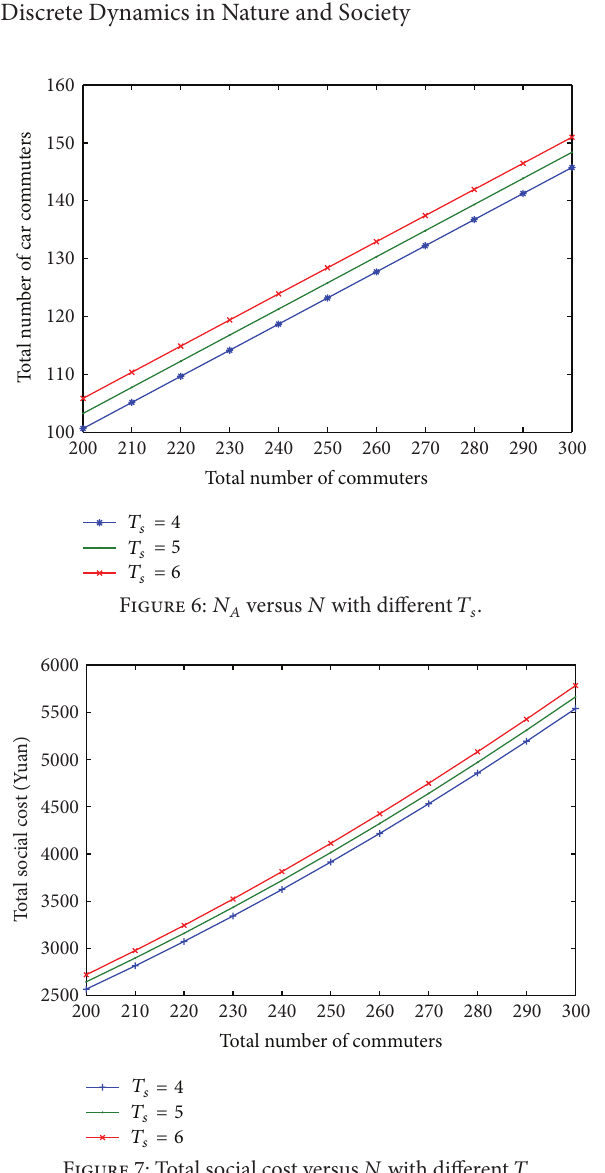
Figure 9: 𝑁 𝐴 versus total demand with different 𝜃 1 .